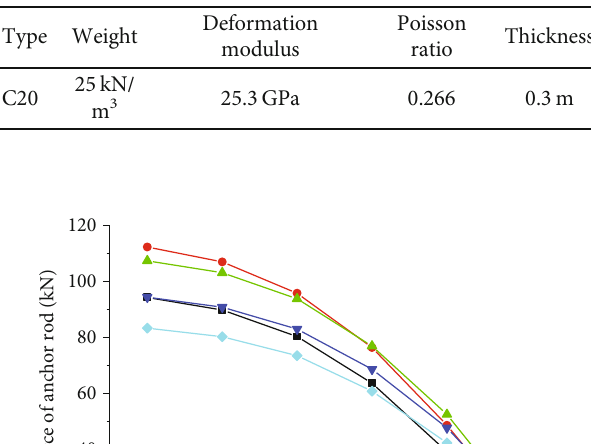
Table 3: Calculation parameters of shotcrete.